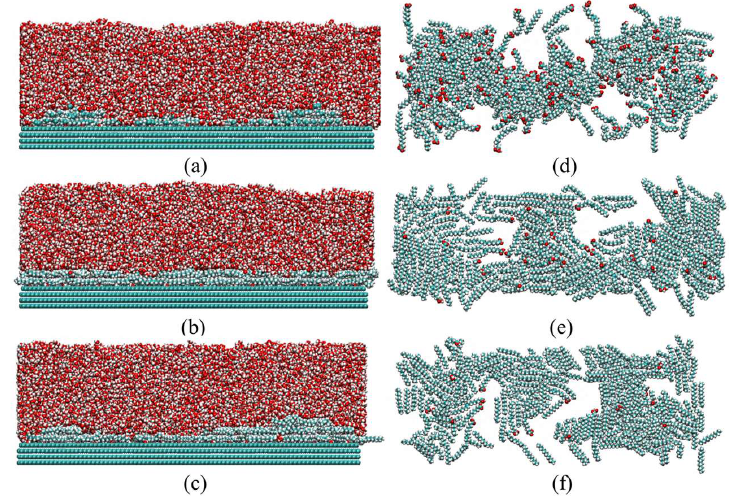
Figure 8. Equilibrium adsorption configuration of the compound collectors of ( a ) OA:DD = 3:1, ( b )